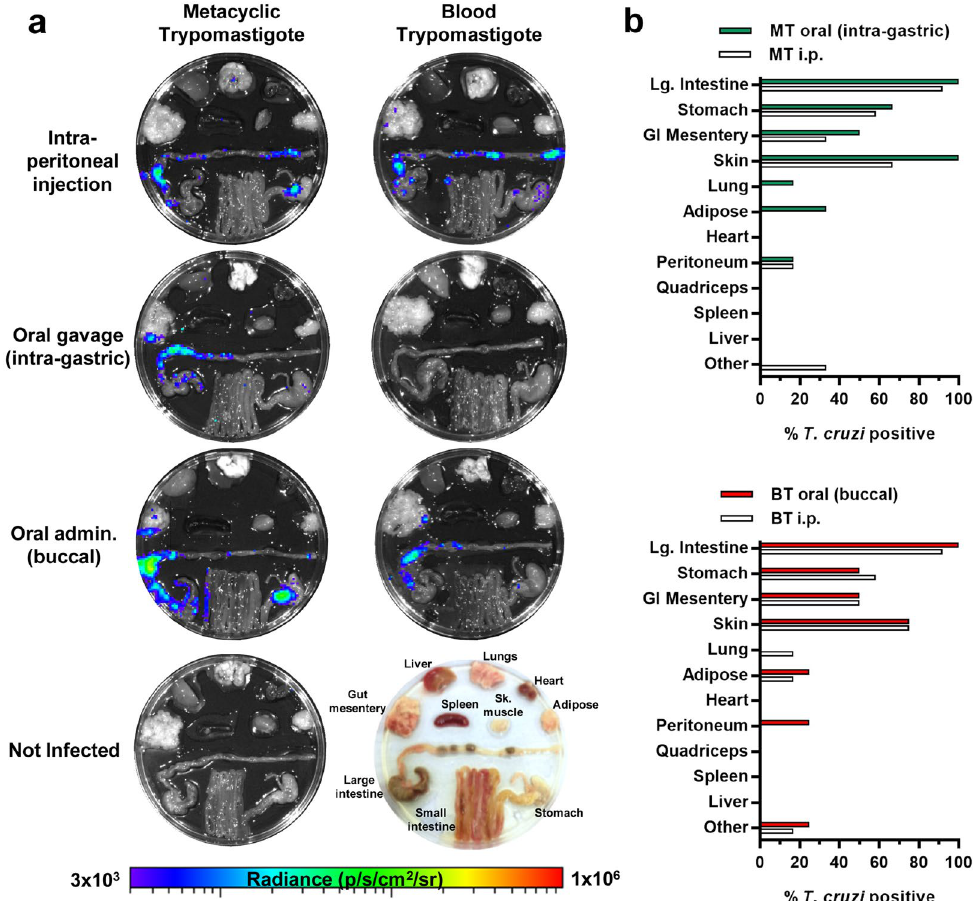
Figure 4. Tissue parasite distribution in mice chronically infected with T. cruzi after oral transmission. ( a ) Representative ex vivo images of tissue-specific parasite bioluminescence at 4 months post-infection. Images show infection distributions and intensities for adipose, gut mesenteric tissue, heart, lung, large intestine, liver, skeletal muscle, spleen, small intestine and stomach. Log-scale pseudocolour heat-maps show intensity of bioluminescence; minimum and maximum radiances are indicated. Tissues and organs are arranged as shown (bottom right). ( b ) Charts show the proportion of animals that had above threshold bioluminescence in the indicated organs and tissue samples. The category “Other” refers to bioluminescence signals in the animal carcass that could not be unambiguously assigned to a specific organ. MT oral (intra-gastric) n = 6, MT i.p. n = 12, BT oral (buccal) n = 4, BT i.p. n =